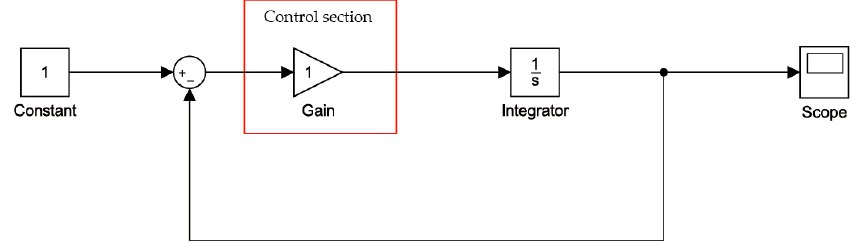
Figure 4. Control strategy of master robot motion.